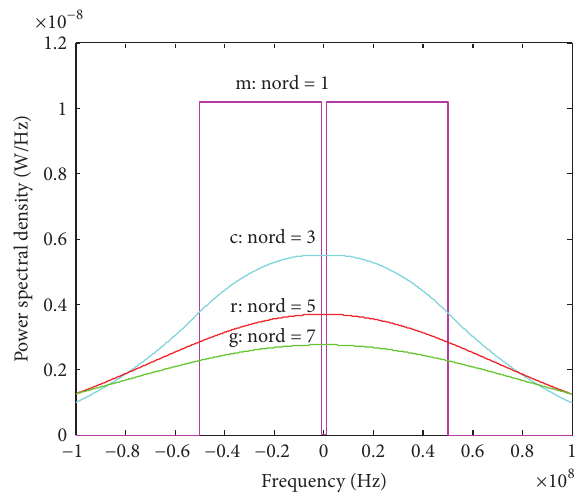
Figure 1: Power spectral density (W/Hz) of various order convolu- tion terms ( 𝐵 𝑇 = 100 MHz, 𝐵 notch = 2 MHz, and 𝜎 2 𝜉 = 1W).